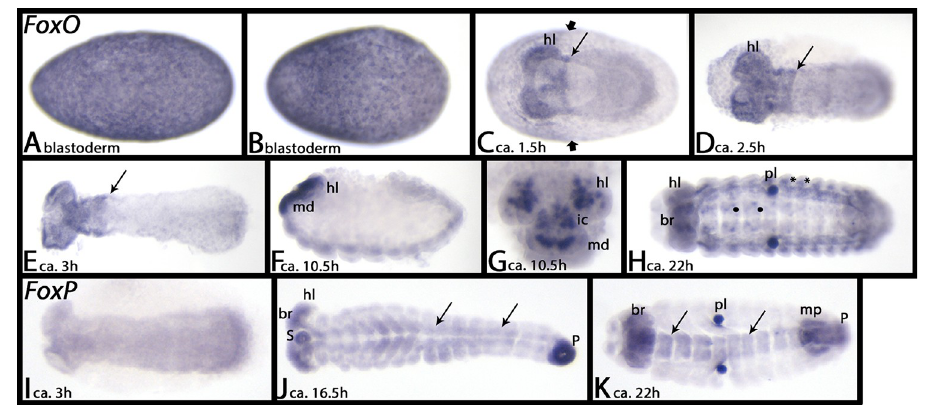
Fig 17. Expression of Tribolium FoxO (A-H) and FoxP (I-K). In all panels, anterior is to the left, ventral view; except panel F, lateral view. In panel G, anterior is up. Embryos in panels E, H, J and K are flat-mounted. Long arrows in panels C and D mark the posterior border of strong expression in the head. Short arrows in panel C mark posterior border of expression in the extraembryonic tissue. Asterisks in panel H mark expression in the lateral tissue of the trunk segments. Filled circles in panel H mark dot-like expression in the VNS. Arrows in panels J and K point to expression in the VNS. Note the unspecific staining of the pleuropodia in panels H and K. Abbreviations in Table 2.